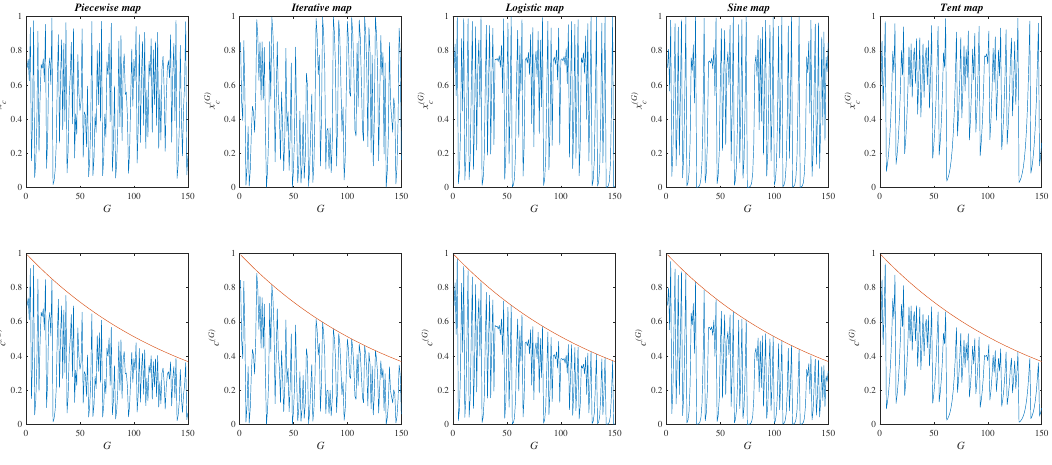
Figure 3. Plot of the employed chaos maps and corresponding chaos based sensory fragrance c ( G ) as a function of generation